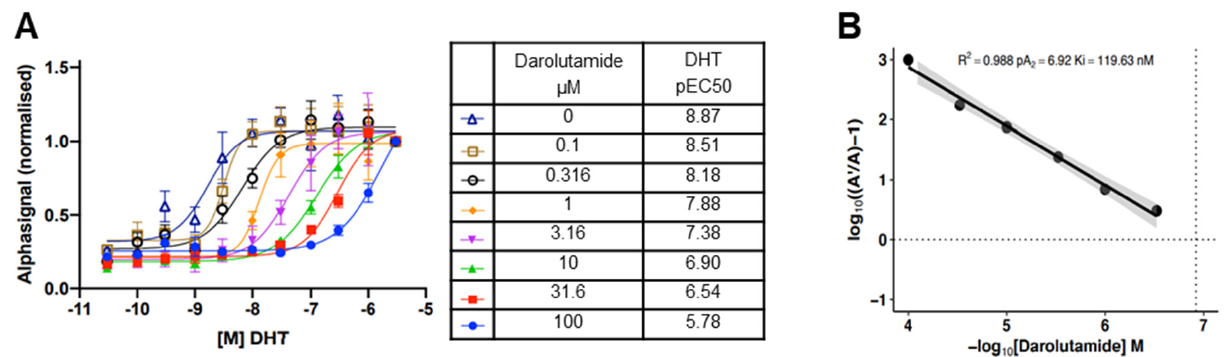
Figure 1. Competitive Ki screening. ( A ) CETSA EC 50 analysis of AR in intact CWR22Pc-R1-AD1 cells treated with DHT, DHT and darolutamide, or DMSO control. Normalized AlphaLISA signals from intact cell samples heated to 46 °C after incubation with a 7-step dilution series of darolutamide (N = 4; n = 8) in the presence of serially diluted DHT. ( B ) Schild plot showing the fold change in agonist CETSA EC 50 at the indicated darolutamide concentration, where A ´ is the darolutamide concentration normalized to the corresponding EC 50 value in the absence of darolutamide ( A ).